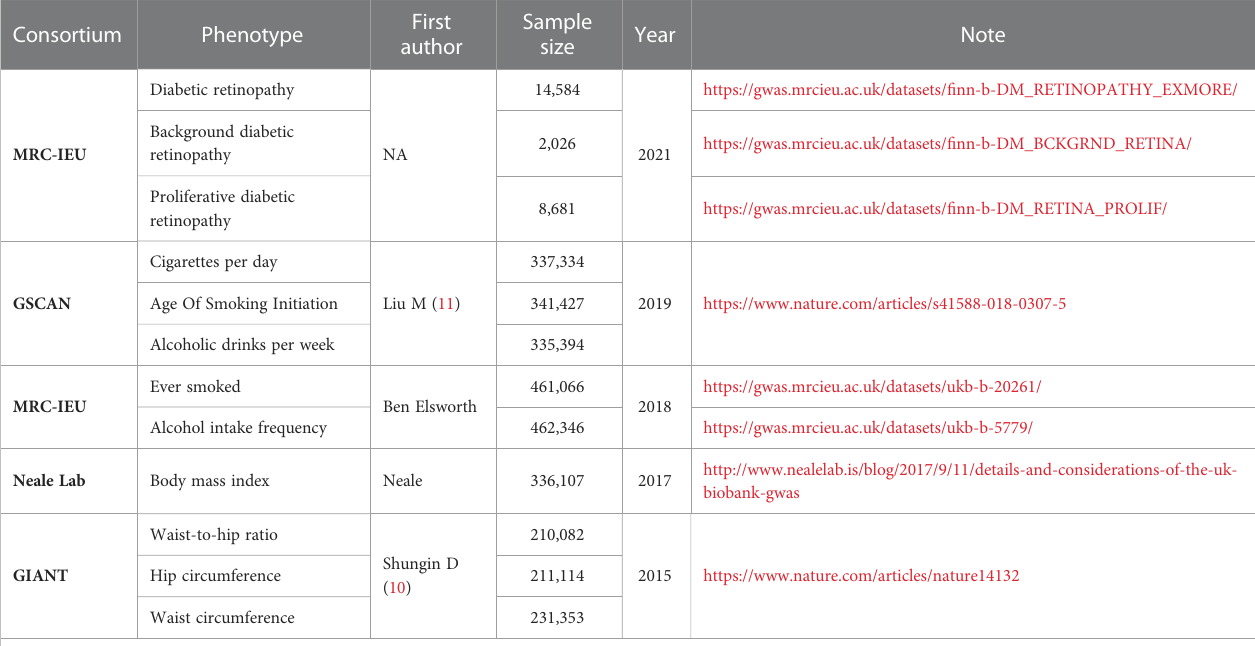
TABLE 1 Details of studies included in Mendelian randomization